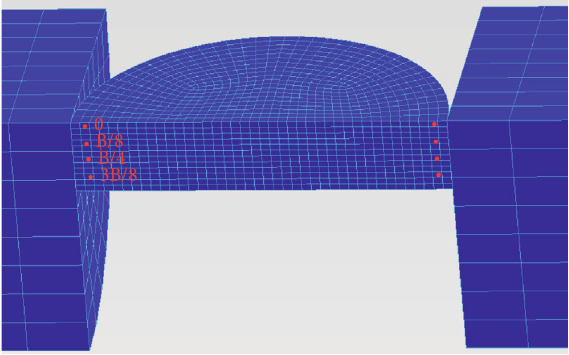
Figure 12: The unit selected at the end of the